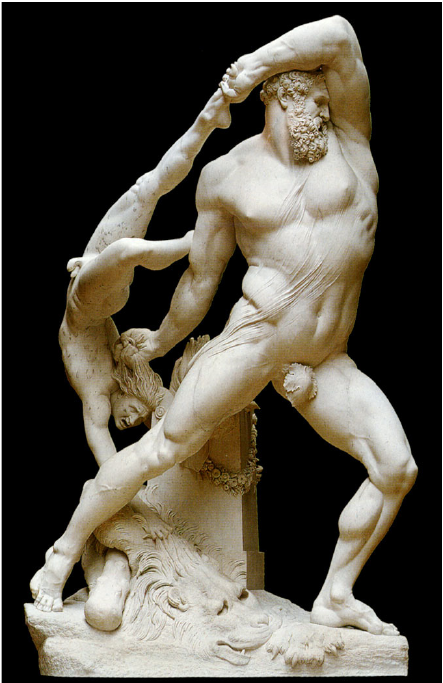
Figure 13. Antonio Canova. Hercules and Lichas , 1815. National Gallery of Modern Art, Rome. Pavel Sorokin’s later Hercules and Lichas (1849; now in the Odesa Fine Arts Museum, Ukraine) was evidently influenced by Canova (Figure 14).